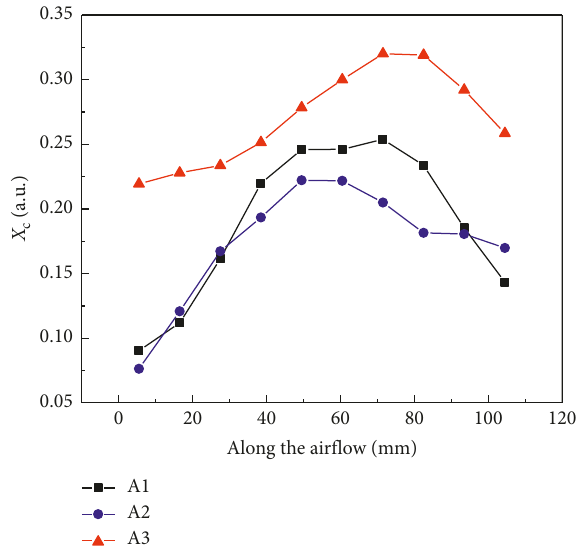
Figure 9: X C data of three oxy-fuel conditions in different